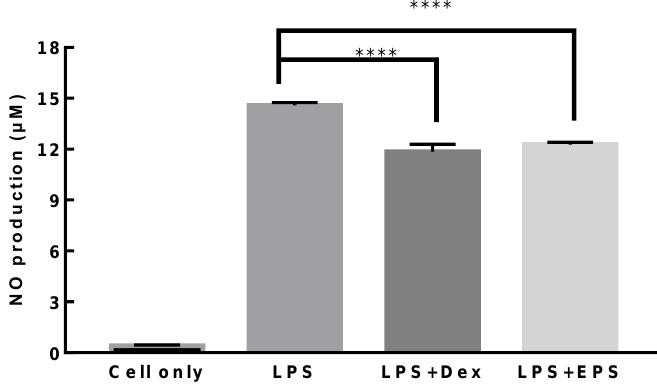
Figure 10. Anti-inflammatory activity of L. paracasei EPS DA-BACS. LPS, 1 μ g/mL of LPS was added to RAW 264.7 cells and incubated for 24 h; LPS+Dex, 1 µM of dexamethasone was added to RAW 264.7 cells and incubated for 2 h, and 1 μ g/mL of LPS was added and incubated for 24 h; LPS+EPS, 1.0 × 10 9 CFU/mL of heat-treated L. paracasei EPS DA-BACS was added to RAW 264.7 cells and in- cubated for 2 h, and 1 μ g/mL of LPS was added and incubated for 24 h. **** show significant differ- ences among groups at p < 0.0001 ( n ≥ 3) using one- way ANOVA and Dunnett’s